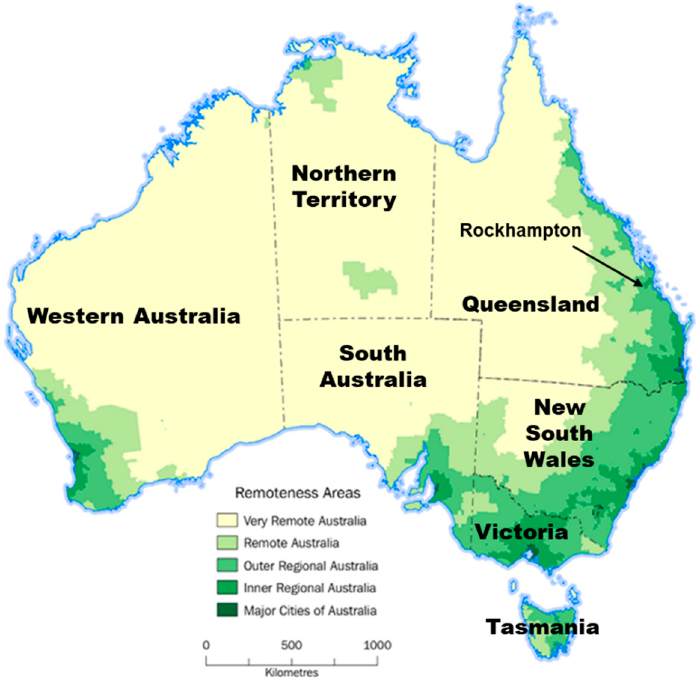
Figure 1. Regional classification of Australia (modified from [23]). The arrow indicates where Rock- hampton is located.